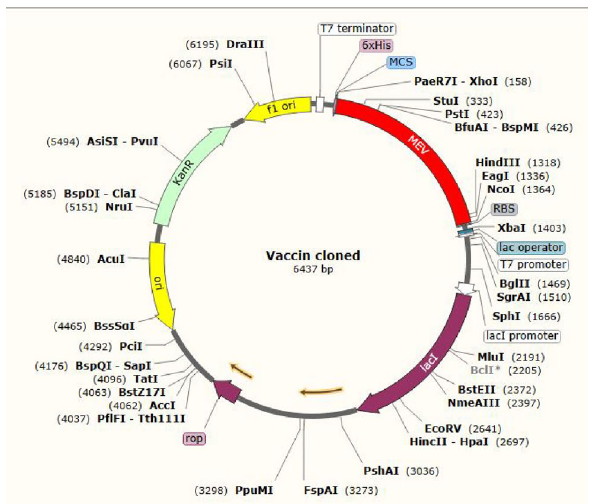
Figure 9. In silico cloning of multi-epitopes vaccine sequence into pET28a (+) expression vector using SnapGene software free-trial (https:// www. snapg ene. com/ free- trial/), the red and gray semicircles represent the multi-epitopes vaccine sequence and the pET28a (+) backbone, respectively.